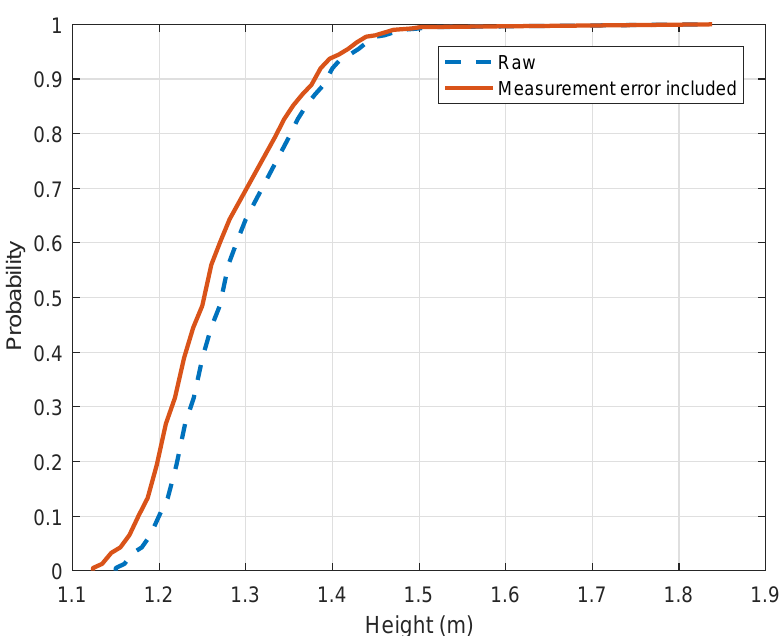
Figure 8. Empirical Cumulative Distribution of Heights of driver eye.